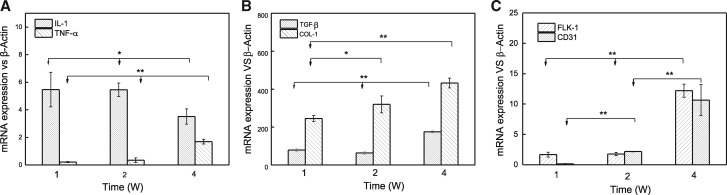
Expression of (A) inflammatory factors of IL-1 and TNF-α, (B) collagen deposition and (C) vascularization-related genes in the infiltrated tissues post-implantation for 1, 2 and 4 weeks. *P < 0.05, **P < 0.01